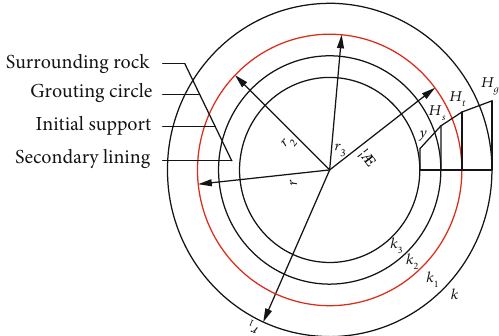
, H , and y are t s